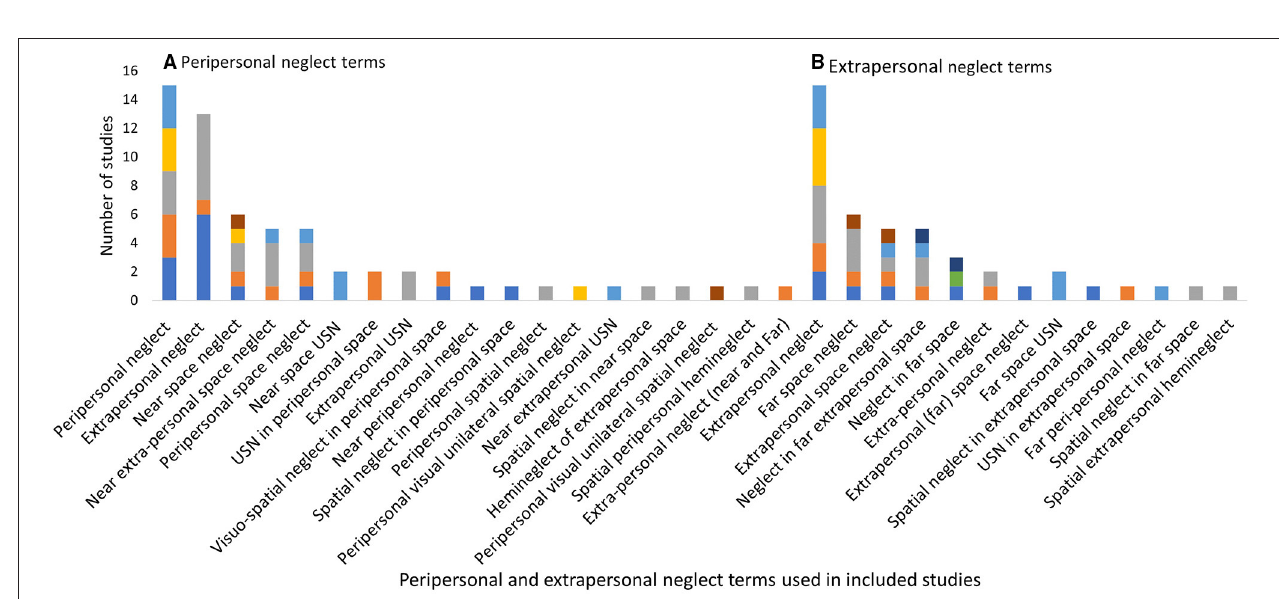
FIGURE 6 | Personal neglect terms used within included studies.